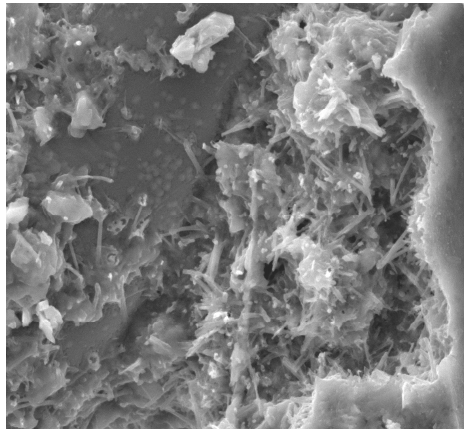
Figure 15. Ettringite crystals formed in close proximity to POFs at 1000× magnification.